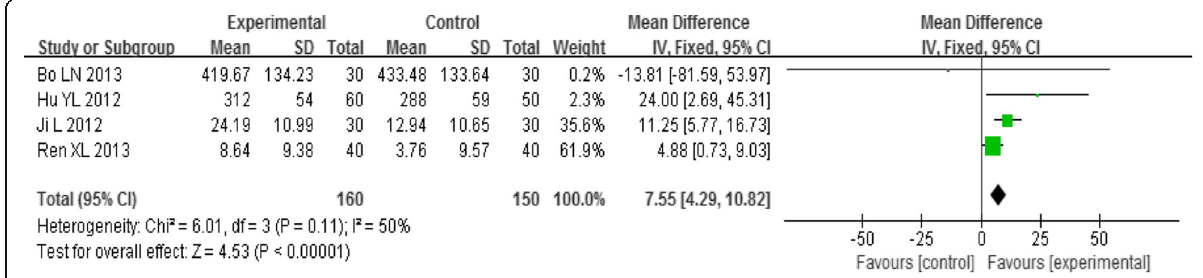
Fig. 5 Meta-analysis of the Peripheral Blood PGF2